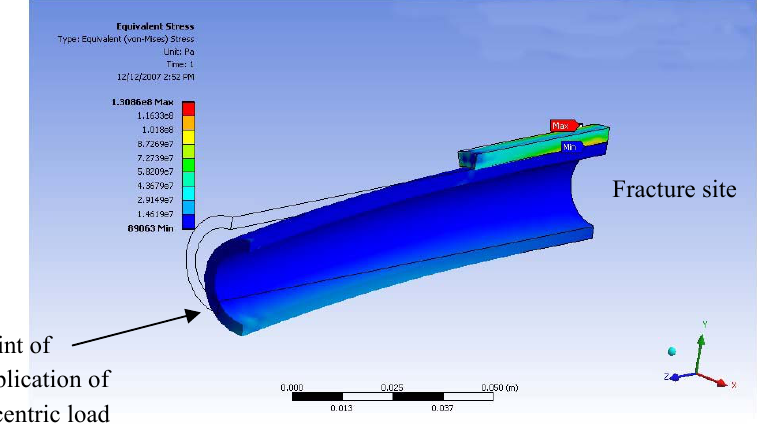
Fig.5 Highly eccentric axial loading of the plated-bone